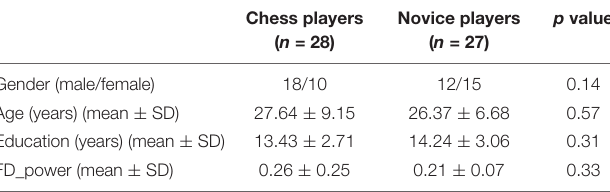
TABLE 1 | Demographics of chess and novice players used in the present